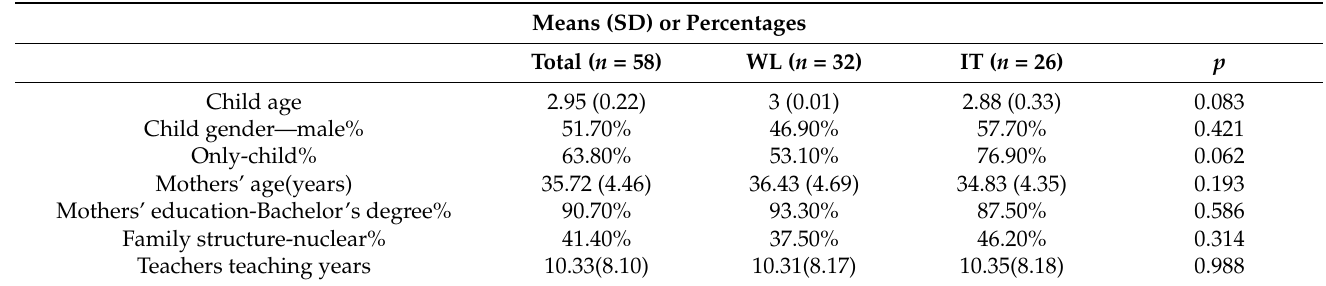
Table 1. Demographic information for the total sample.